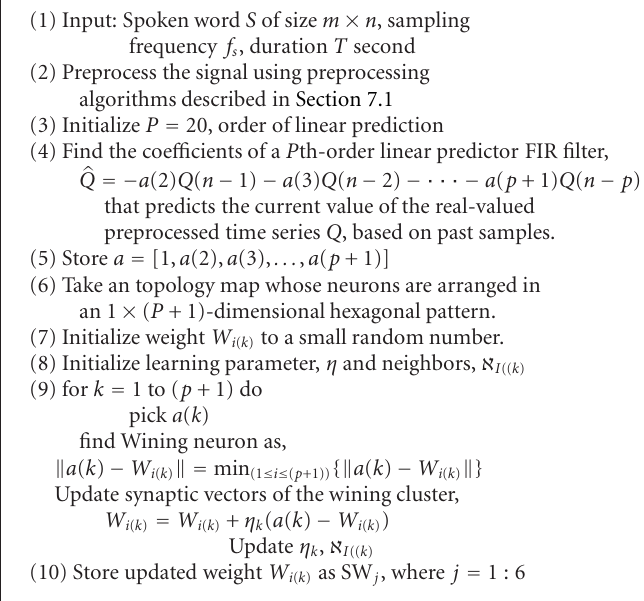
Algorithm 1: SOM weight vector extraction algorithm.